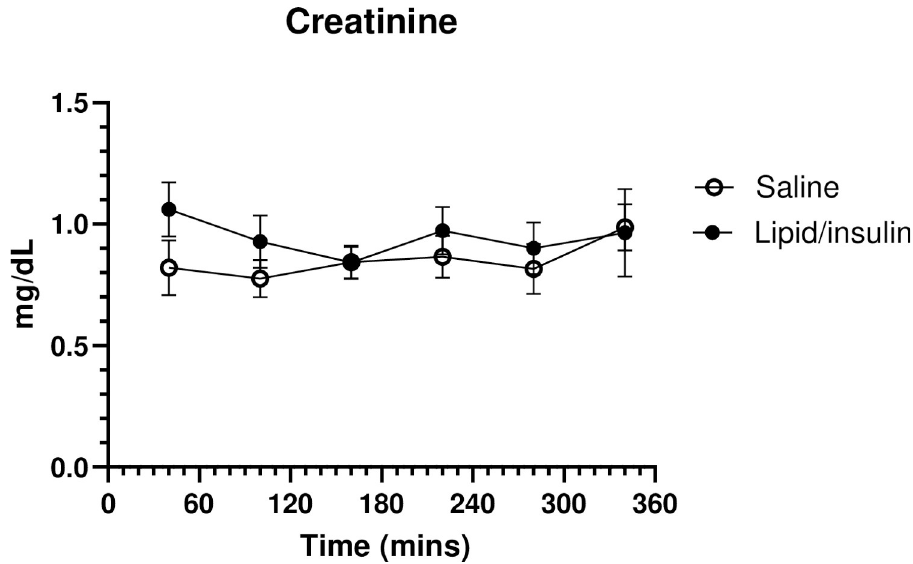
Fig 3. Creatinine levels are unaffected by lipid/insulin, confirming there is no hemodilution occurring. Pooled levels of serum Creatinine were measured, as described in methods, approximately every hour; values are mean ± SEM; n =